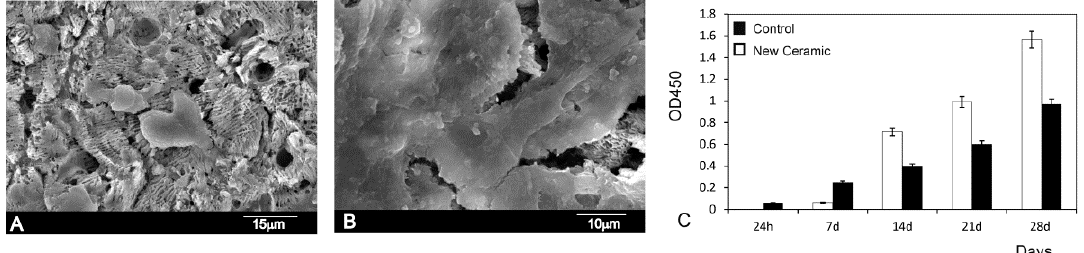
Figure 9. SEM images of the hMSCs-A cultured on eutectoid ceramic surface at ( A ) 24 h; ( B ) 28 days; and ( C ) Proliferation rate of hMSCs-A measured by MTT absorbance at different times of the